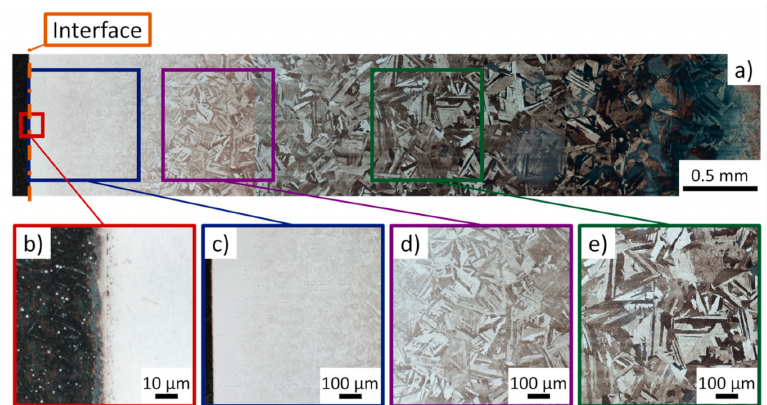
Figure 3. Optical micrographs of Kalling 2 etched samples of composite B (cold work tool steel and maraging steel): ( a ) Overview of maraging steel and the interface, ( b ) Decarburized zone of tool steel 2, ( c ) Slightly etched area with carbides in the matrix and at grain boundaries, ( d ) Slightly etched Nickel martensitic region ( e ) Nickel